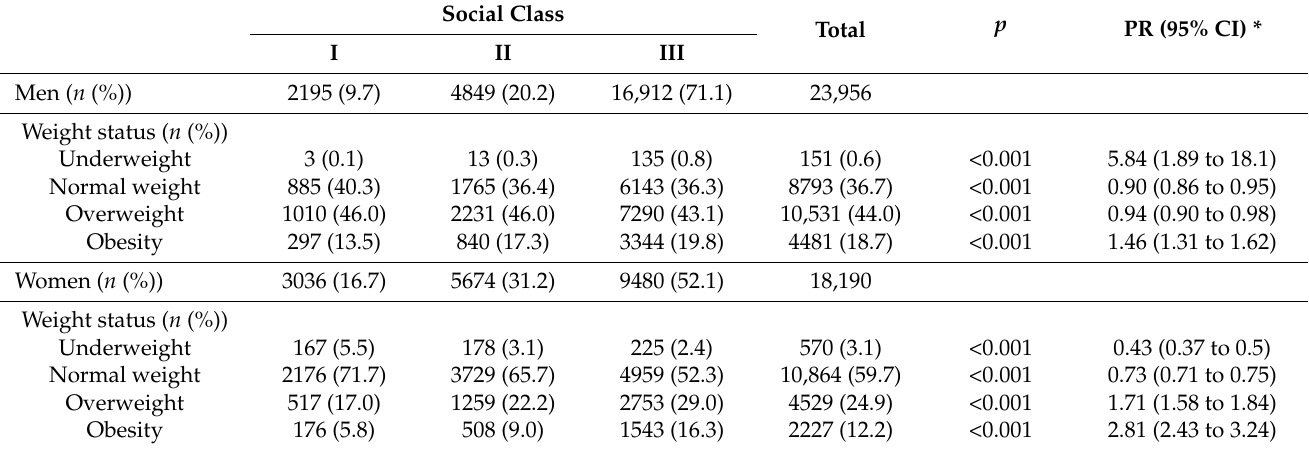
Table 3. Weight status stratified by social class in men and